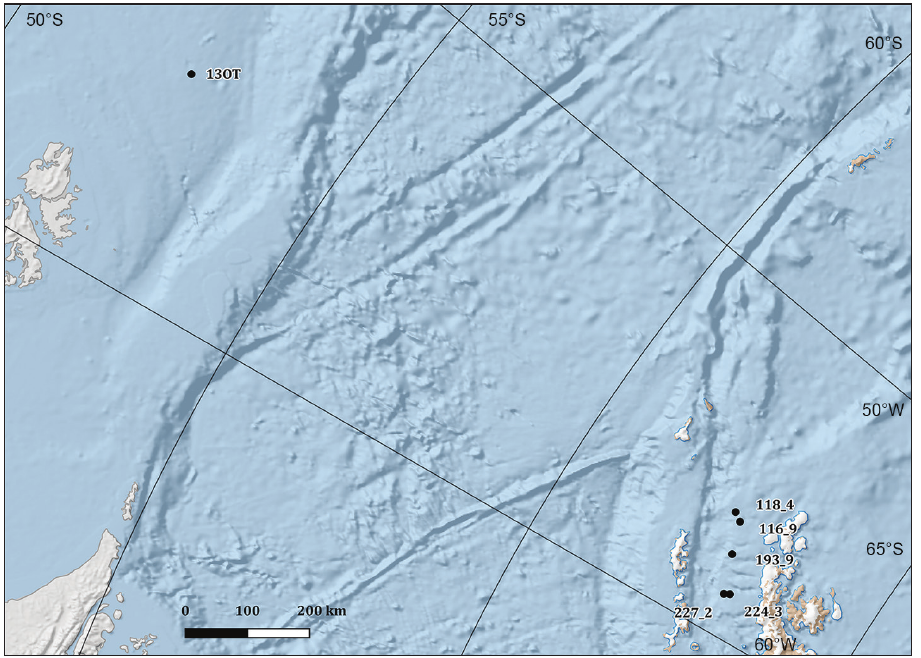
Figure 5. Map with the sampling sites in the Falkland Islands (Islas Malvinas) and Bransfield